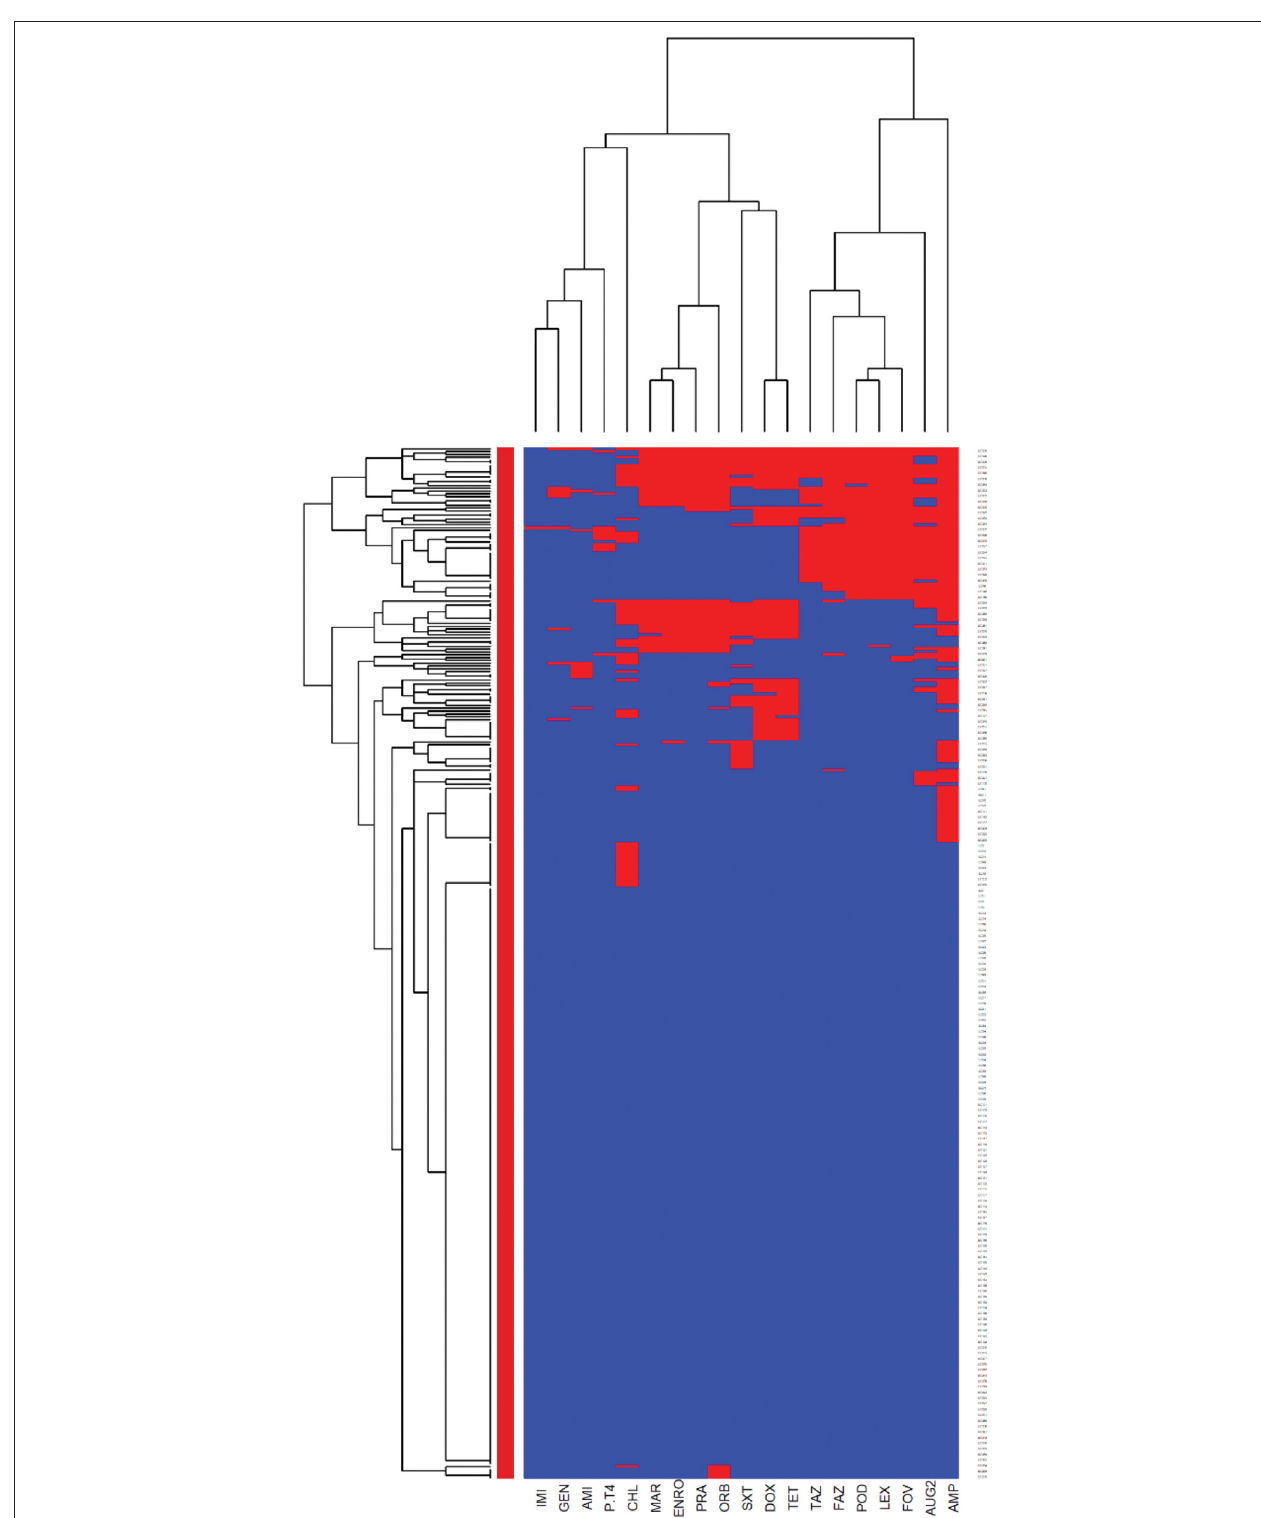
FIGURE 4 | Antimicrobial resistance clustering dendrogram of Escherichia coli isolated from canine urine samples a,b,c . a AMI, Amikacin; GEN, gentamicin; AUG2, amoxicillin-clavulanic acid; PT4, piperacillin-tazobactam; FAZ, cefazolin; FOV, cefovecin; POD, cefpodoxime; TAZ, ceftazidime; LEX, cephalexin; IMI, imipenem; SXT, trimethoprim-sulfamethoxazole; ENRO, enrofloxacin; MAR, marbofloxacin; ORB, orbifloxacin; PRA, pradofloxacin; AMP, ampicillin; CHL, chloramphenicol; DOX, doxycycline; TET, tetracycline. b Red color, resistant; blue color, susceptible. c Heatmap generated by hierarchical clustering of the antimicrobial resistance determinants (columns) of bacterial isolates